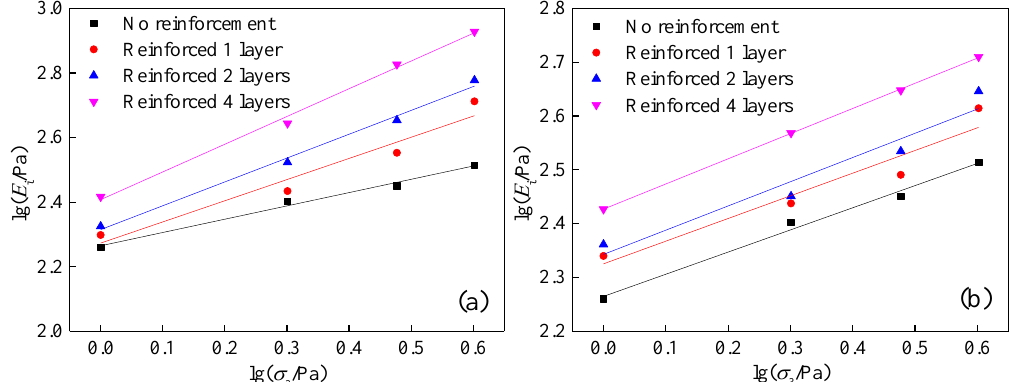
Figure 6. lg( E i / Pa)–lg( σ 3 / Pa) relation curves of di ff erent reinforced layers of tailings: ( a ) geogrids, Figure 6. lg( E i /Pa)–lg( σ 3 /Pa) relation curves of different reinforced layers of tailings: ( a ) geogrids, ( b ) ( b ) geotextiles.